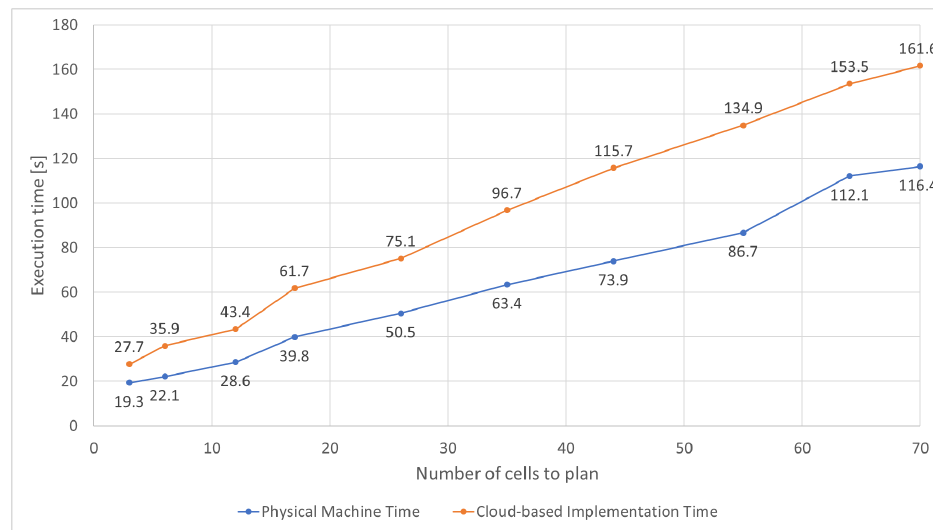
Figure 20. Comparison of the CPSP algorithm execution times between a physical machine and the cloud-based